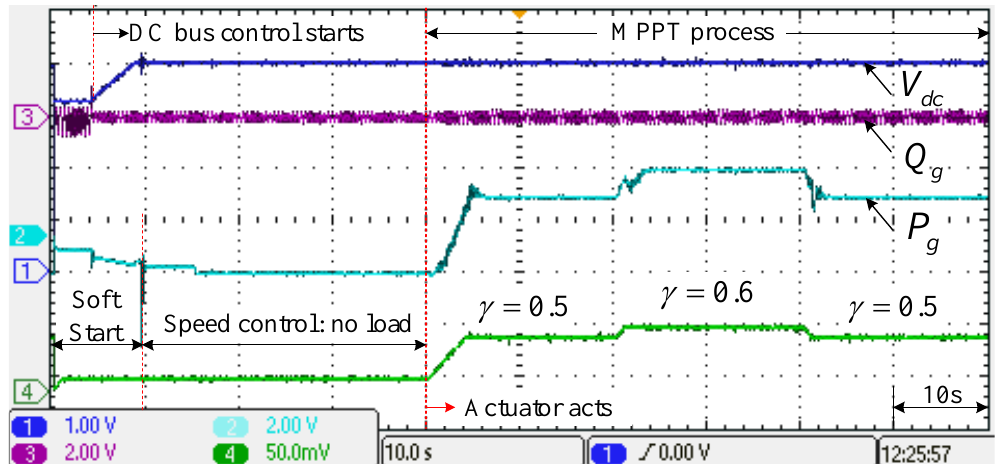
Figure 16. Grid-side control performance, the DC-link voltage V dc (100 V/div), the active power P g (200 W/div), the reactive power Q g (200